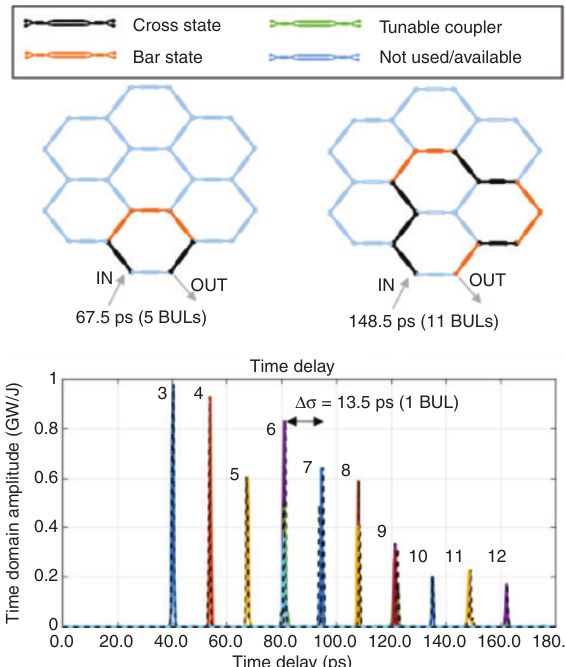
Figure 13: Discrete optical delay lines programmed over the silicon hexagonal waveguide mesh of Figure 9A. (Up) Settings for two different time delays corresponding to 5 and 11 BULs, respectively. (Bottom) Measured delays up to 12 BULs (after Ref.